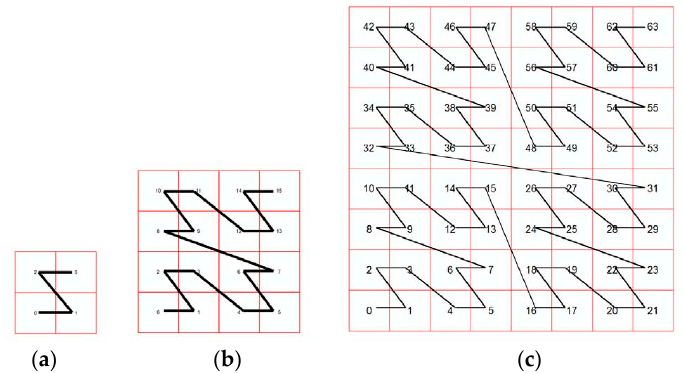
Figure 1. Square unit, its decomposition in a regular grid and the scanning order introduced by the Lebesgue curve (Morton order): ( a ) order ν =1; ( b ) order ν = 2; ( c ) order ν =3.